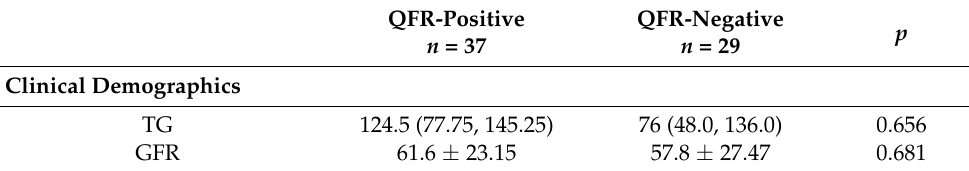
Table 1: Variables are displayed as mean ± SD when a normal distribution is present, or as median (1st–3rd quartile) when a normal distribution is not present. For each variable, the percentage of patients involved ( n %) is given.